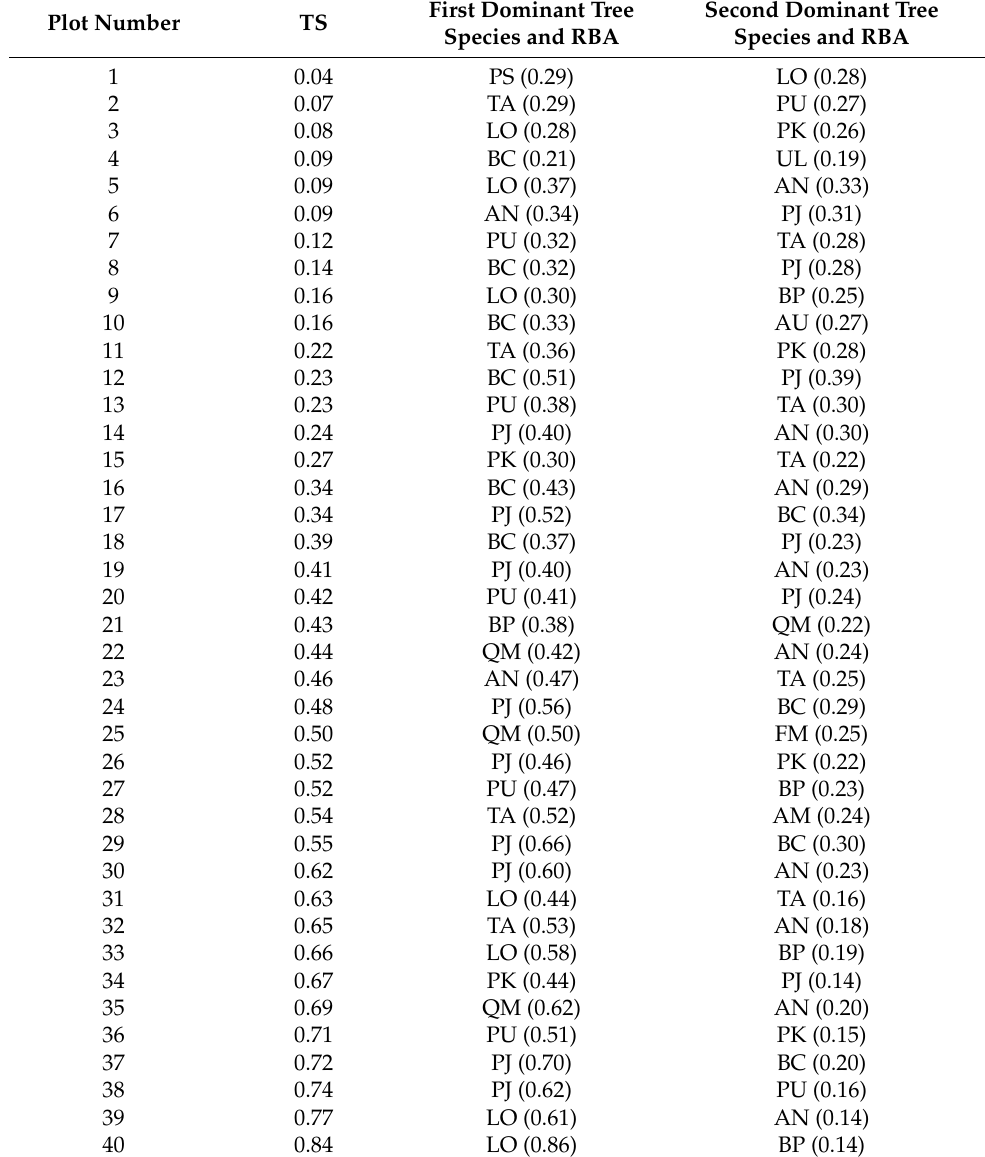
Table 1. Temporary stability (TS), the first two dominant tree species, and the relative basal area (RBA) value in different